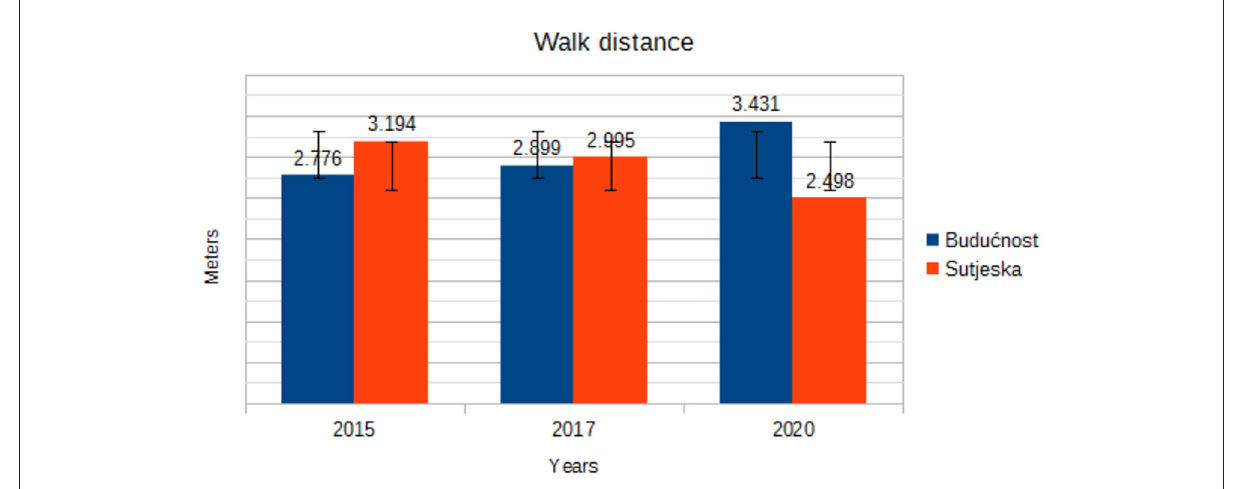
FIGURE2 Trend in mean walk distance by